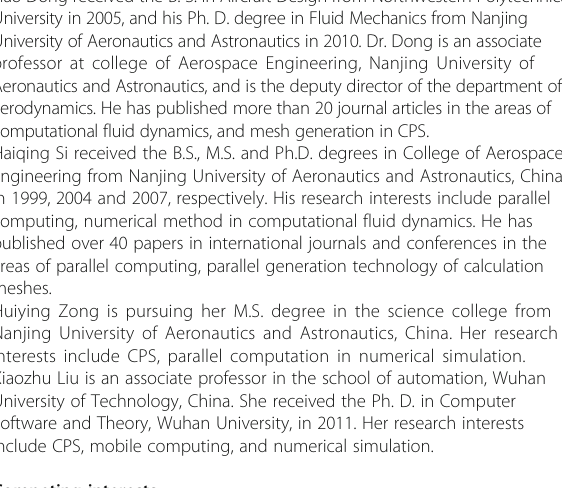
parallel unstructured grid generation algorithm. Fig- ures 9, 10, and 11 depict sub-grids, interface grids, and